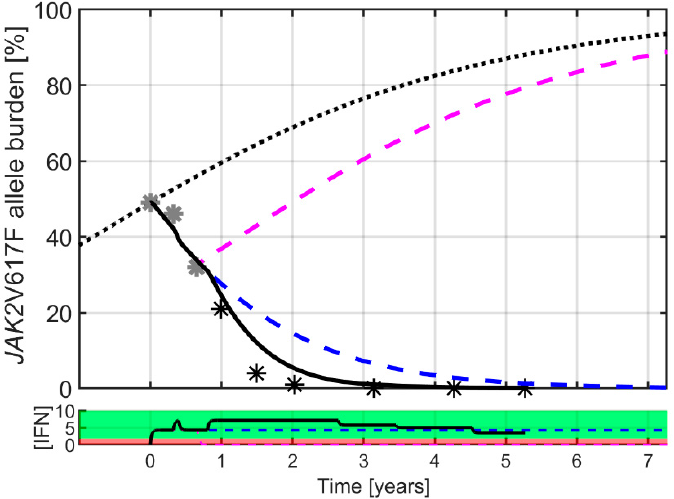
Figure 8. Different hypothetical modelling treatment scenarios: treatment discontinuation and prolonged treatment, respectively. Pausing the treatment after month 8 predicts a relapse of the cancer, and the pre-treatment JAK2 V617F value is reached after 1.6 years (pink dashed curve). In contrast, prolonged treatment suppresses the cancer in the model (black solid curve) even with a lower dose (blue dashed curve). The model average daily IFN dose in µ g is indicated in the lower panel, with line colors corresponding to those in the upper panel. Patient-specific model prediction for all patients exposed to hypothetical treatment discontinuation and prolongation, respectively, are depicted in Supplementary Material